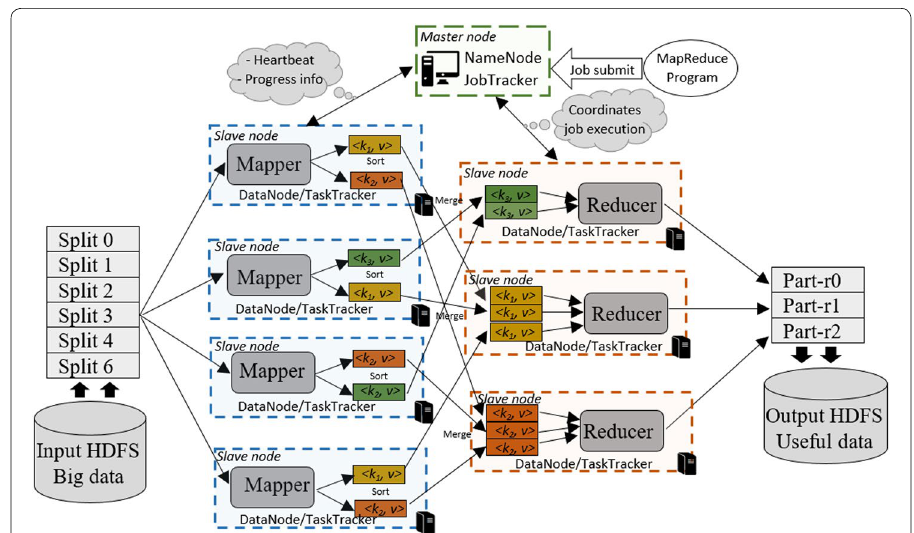
Fig. 1 The job execution workflow of MapReduce